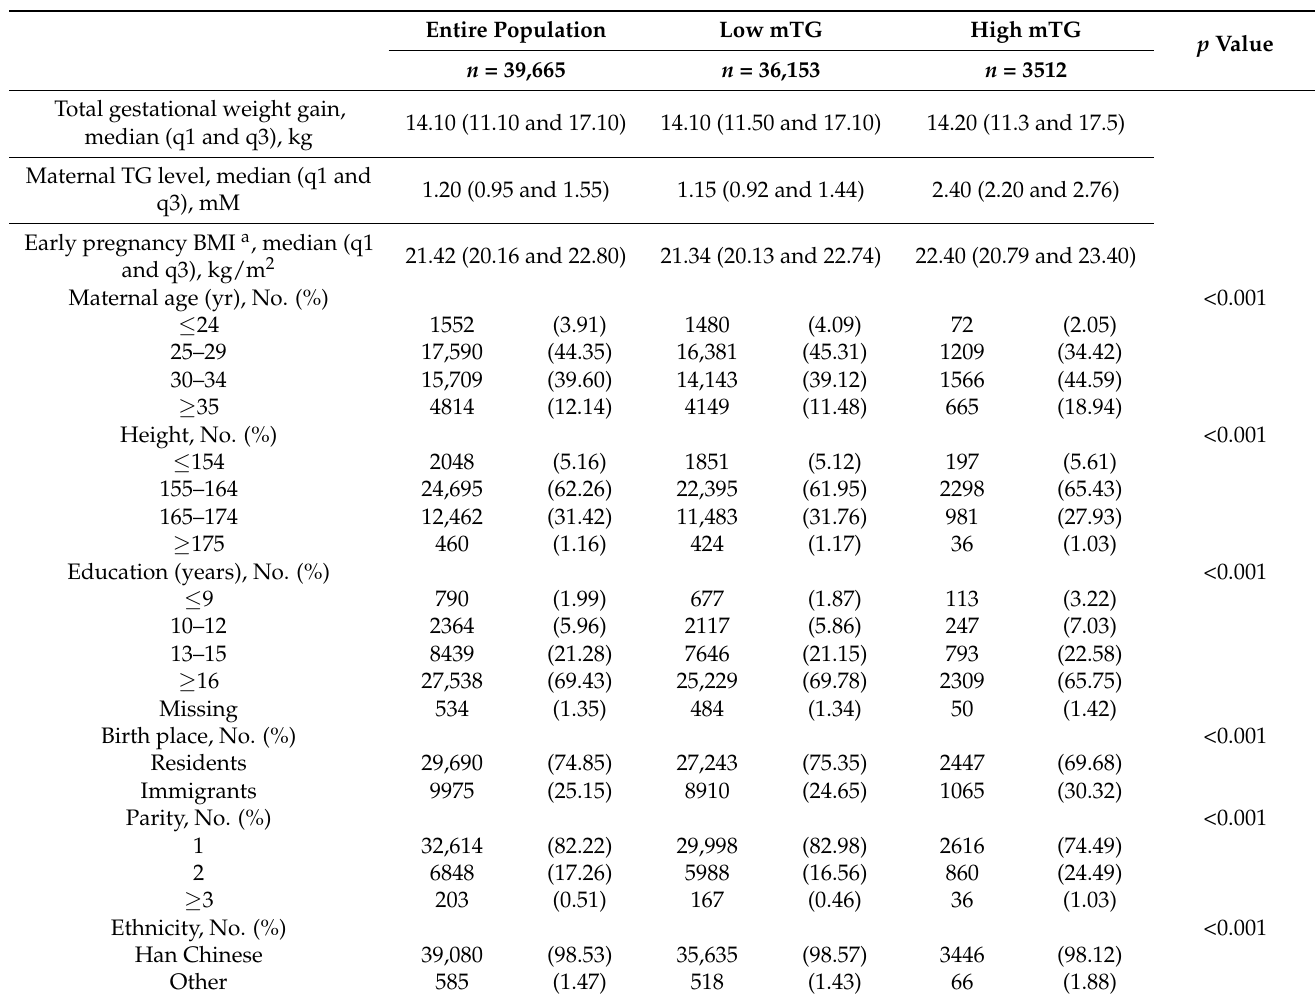
Table 1. Characteristics of study